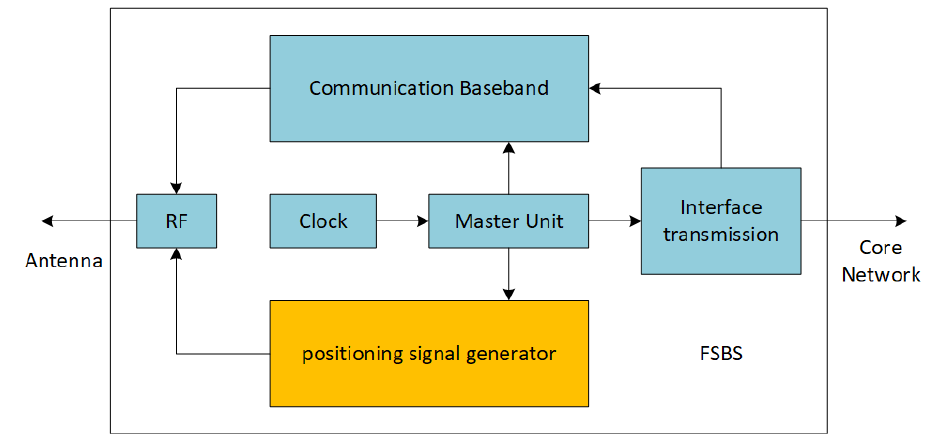
Figure 1. Structure of FSBS.